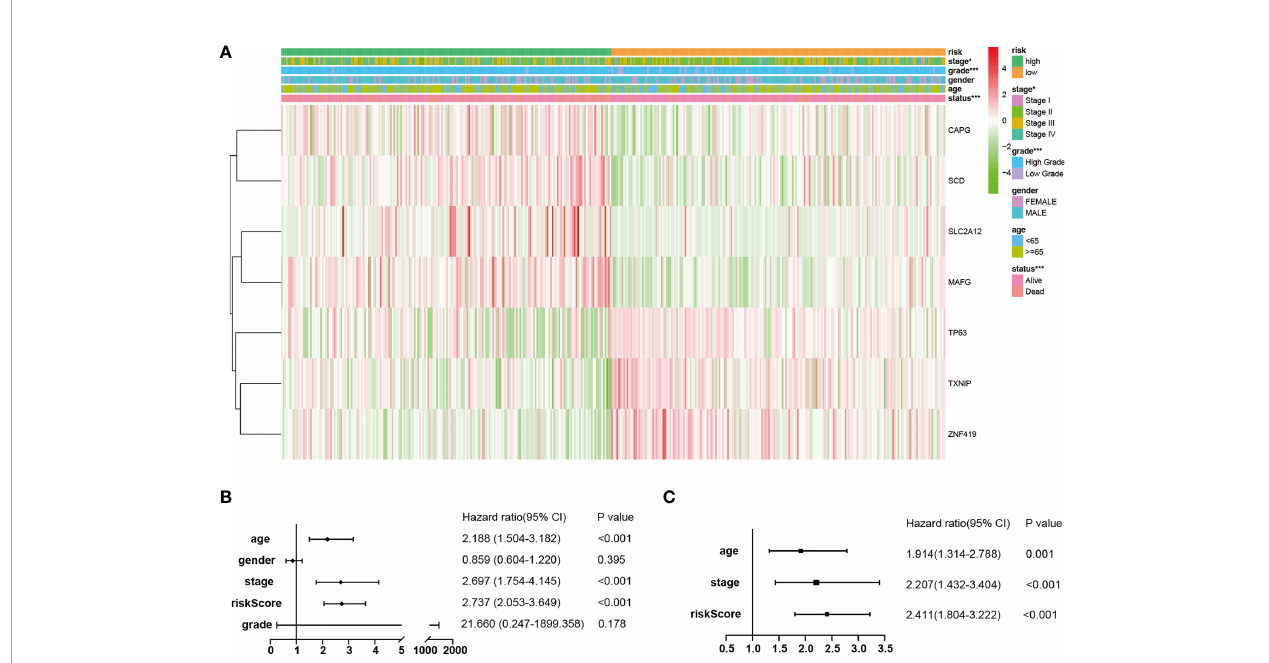
FIGURE 4 | Independent prognostic values of the FRPM. (A) Correlations between the risk groups and the clinical traits. (B, C) Univariate and multivariate regression analysis results of the relationships between the FRPM and the clinical features. *P < 0.05, ***P <